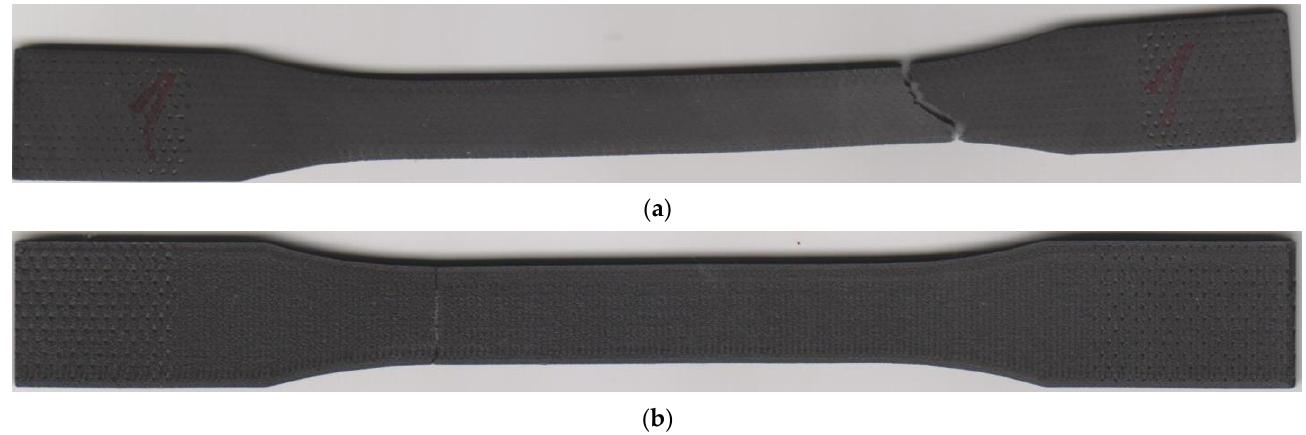
Figure 11 . Fractured specimens: ( a ) infill orientation 45/ − 45; ( b ) infill orientation 0/90. The elongation values allow the determination of normal strains at yield point and normal strains at fracture (Figure 12). In all cases, the normal strain within the elastic region was approximately at the same values, from 3 to 5%.